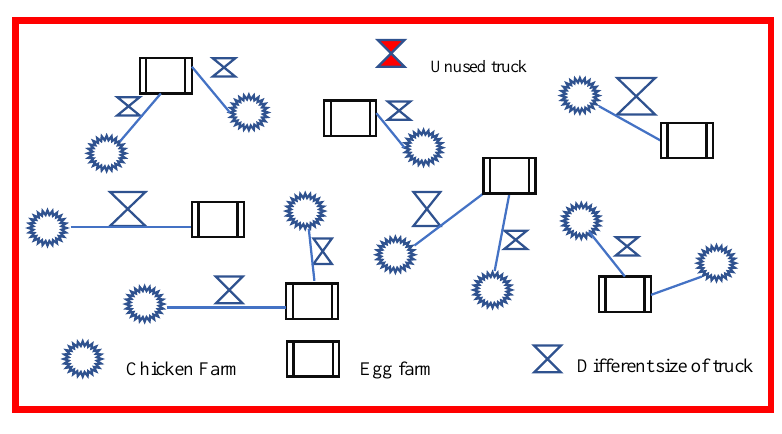
Figure 1. Unsolved problem. MCA 2018 , 6 , x